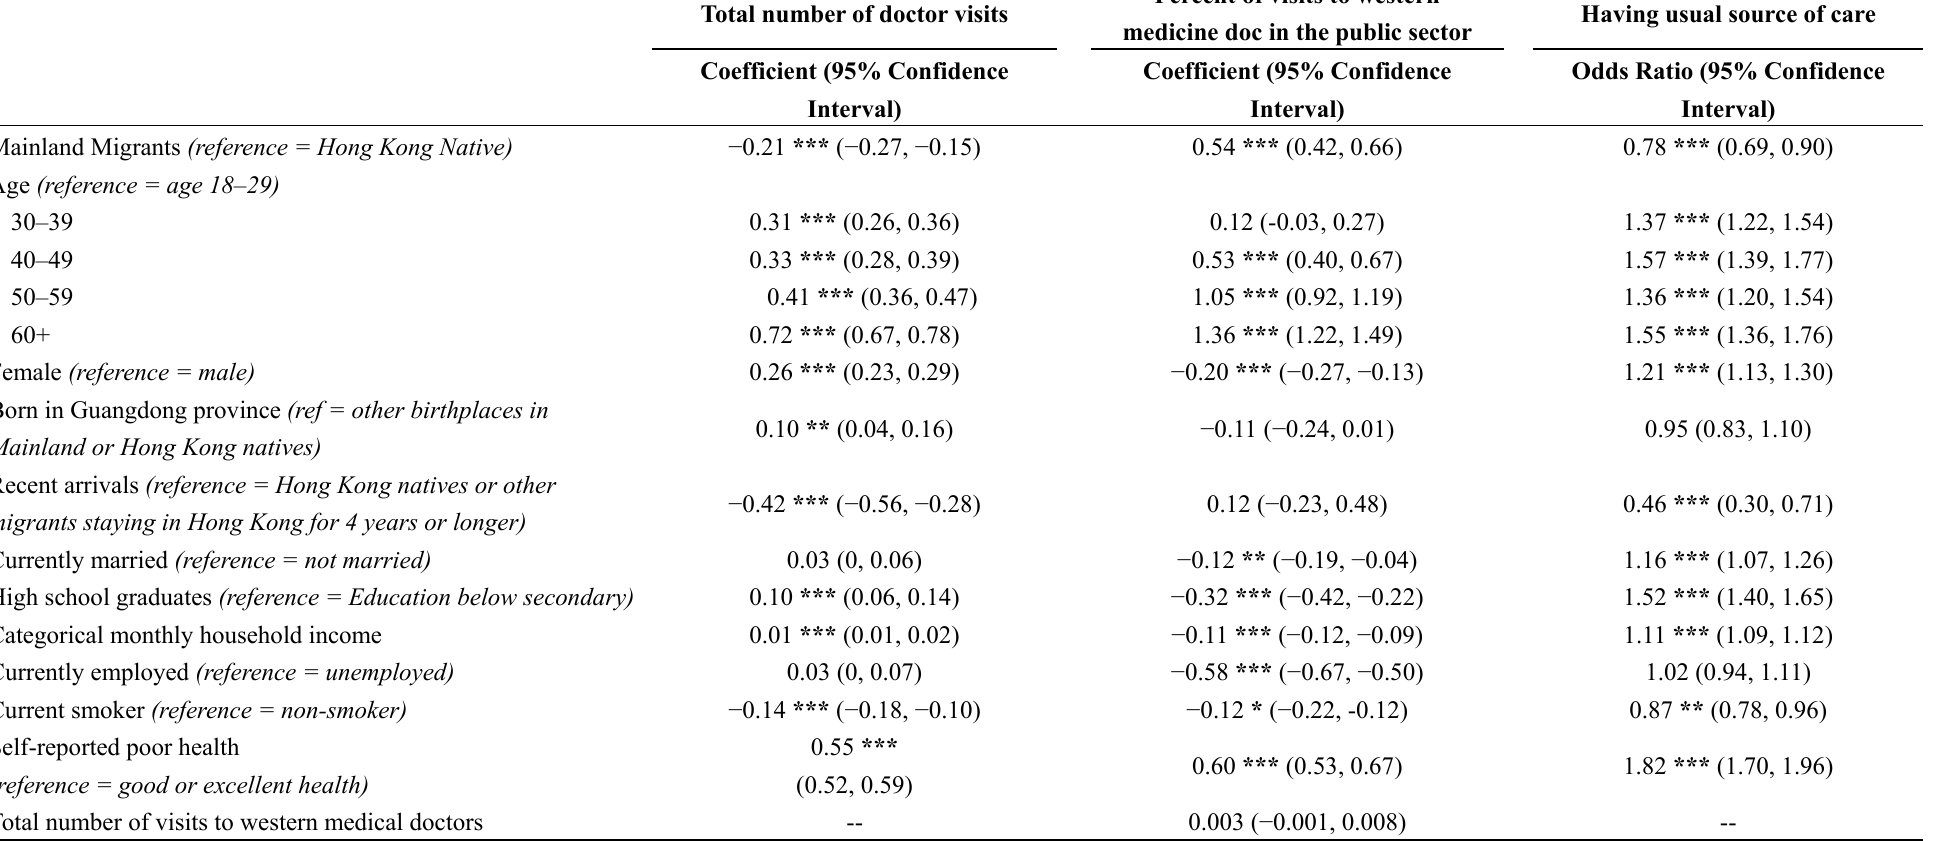
Table 5. Regression results of health care utilization among Hong Kong adult